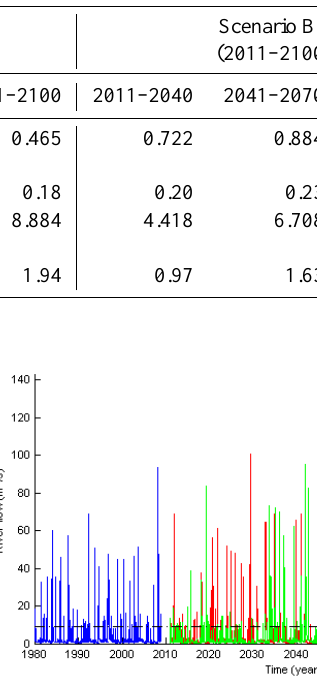
Table 6. Parameters of the GP distribution estimates for the Anoia sub-basin, together with its standard errors.